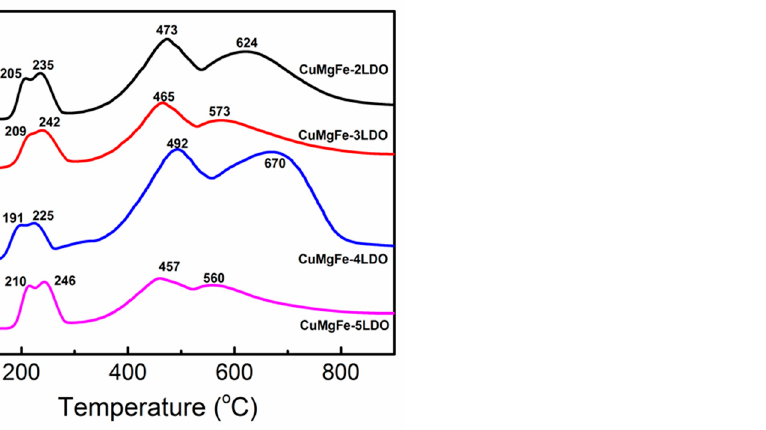
Figure 4. Hydrogen temperature-programmed reduction (H 2 -TPR) profiles of CuMgFe-xLDO catalysts.